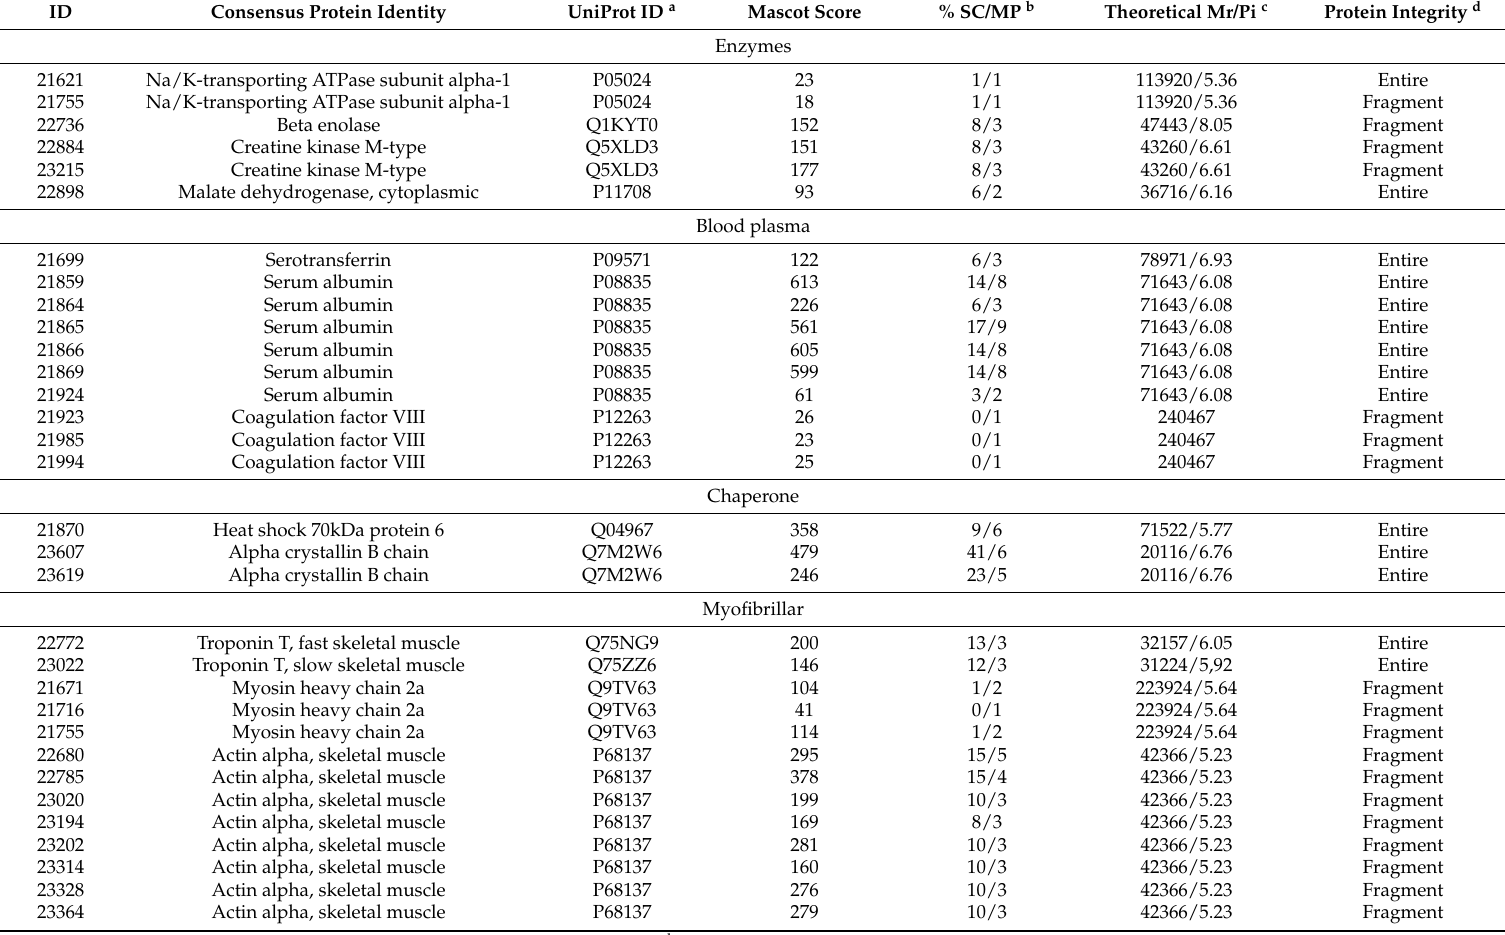
Table 4. List of protein spots identified by mass